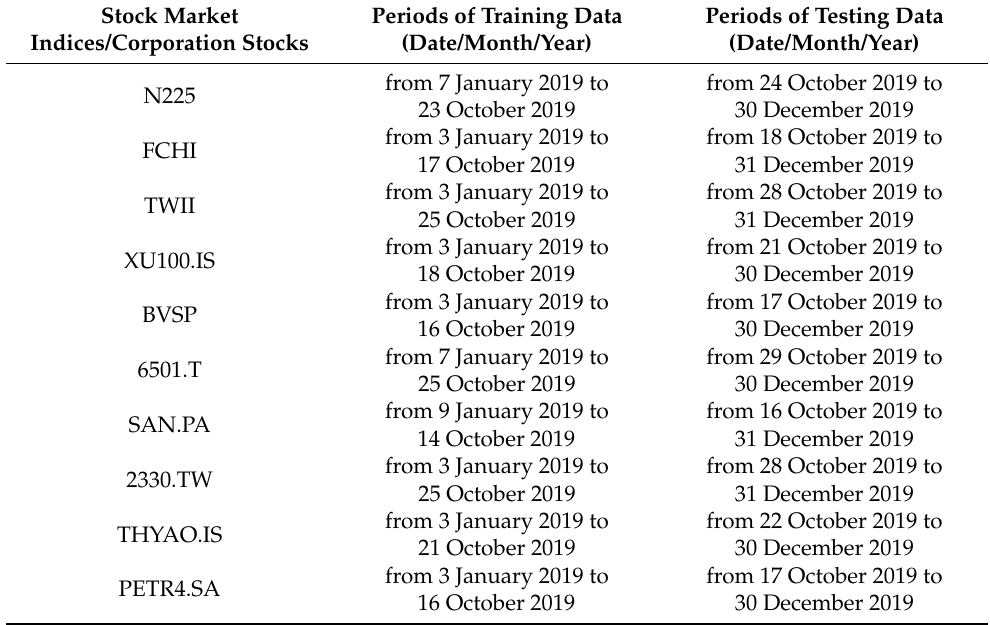
Table 6. Periods of training data and testing data for stock market indices and corporation stock prices. Stock Market